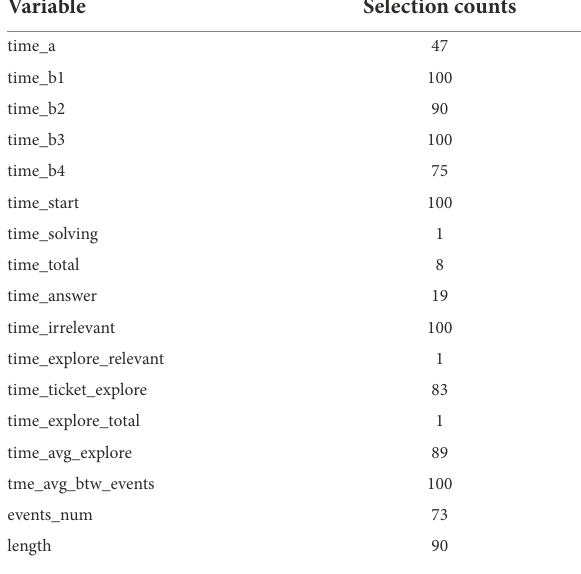
TABLE 3 Variables selection counts out of 100-times repeats for students with the correct